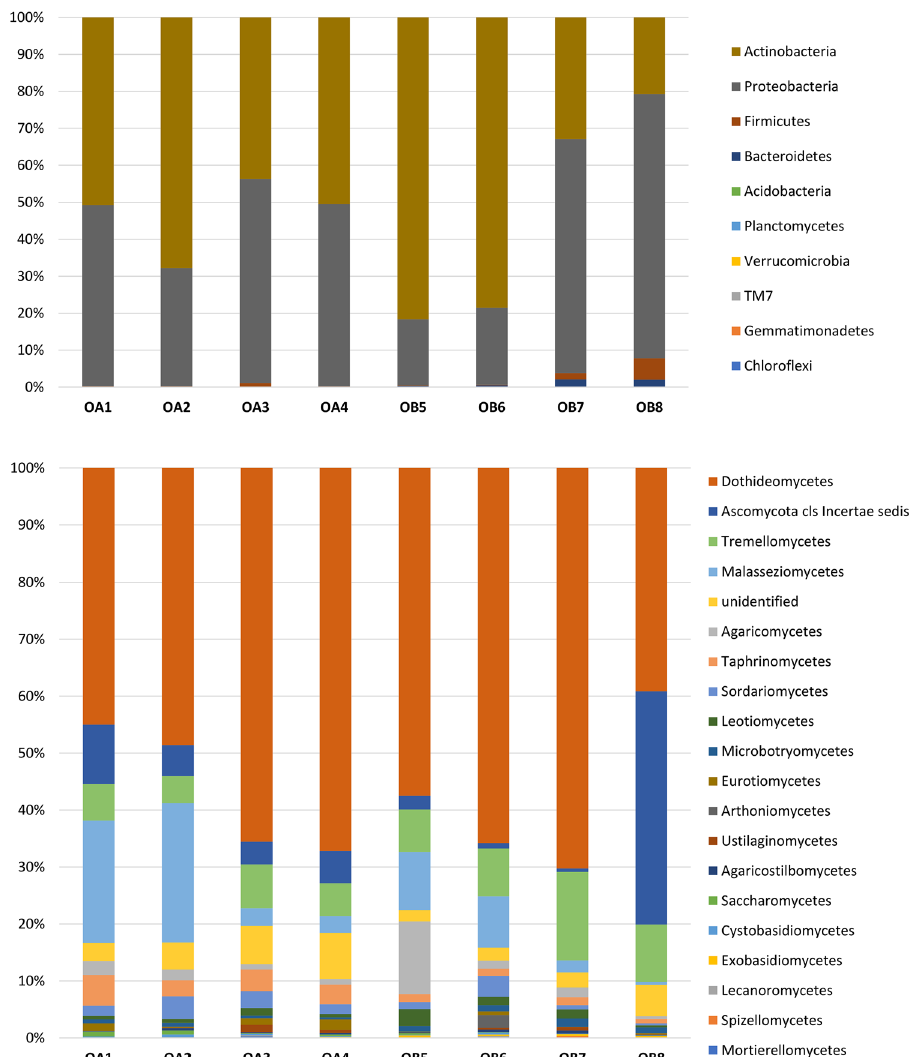
Figure 1. Changes in the composition of bacterial (phylum level; top) and fungal (class level; bottom) communities inhabiting Orobanche alsatica (OA) and O. bartlingii (OB) in immature stigmas from closed flowers (1, 2, 5, 6) and mature stigmas from opened flowers (3, 4, 7,